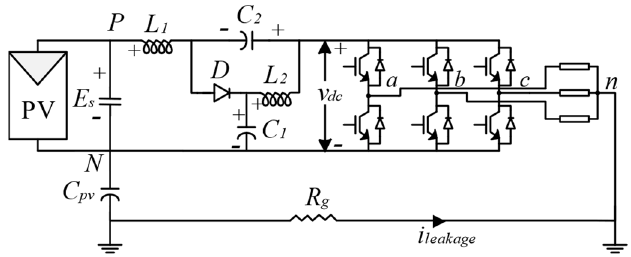
Figure 6. Circuit diagram of three-phase QZSI.